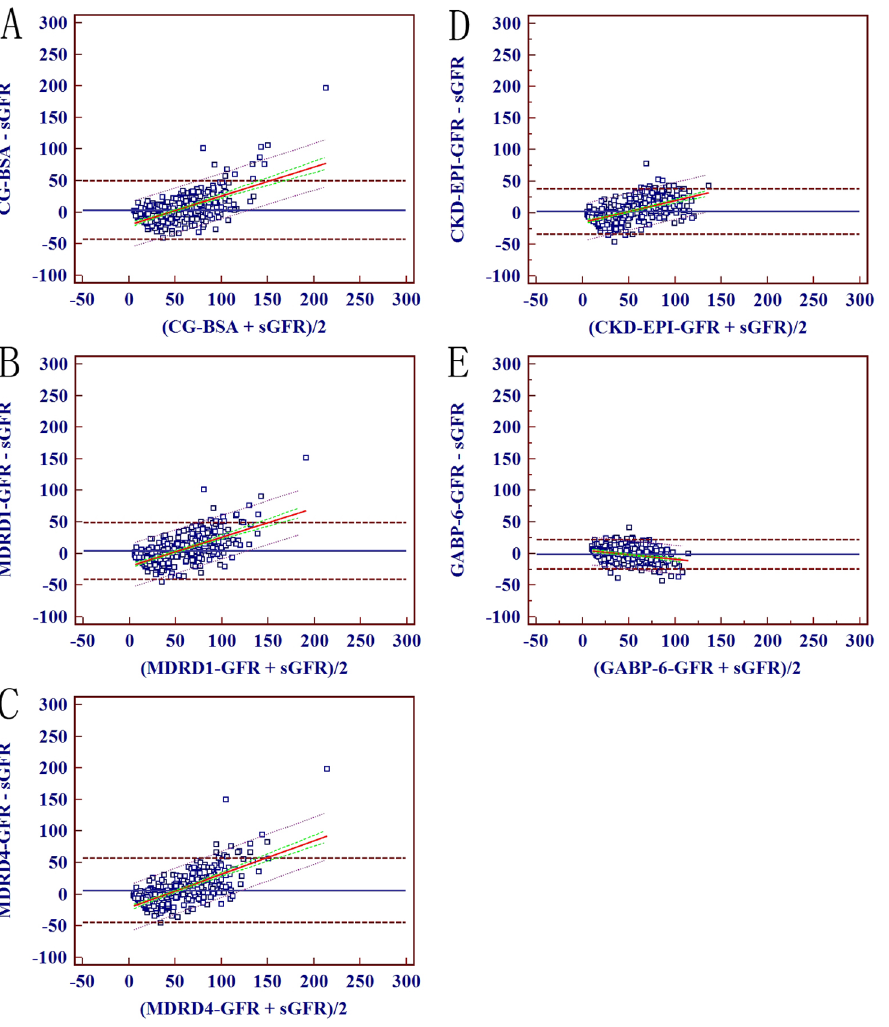
Figure 1. Bland–Altman plot of eGFR and sGFR (ml/min/1.73 m 2 ) in the external validation data set. Solid blue line represents the mean of difference between methods; dashed brown lines represent 95% limits of agreement of the mean of difference between methods; solid red line represents the regression line of difference between methods against average of methods; dotted green lines represent 95% confidence intervals for the regression line, and dashed purple lines represent 95% limits of agreement of the regression line. A, B, C, D and E represent for the results of GFR estimated by the Cockcroft-Gault equation, the six variable MDRD equation, the four variable MDRD equation, the CKD-EPI equation and the six variable GABP network, respectively. Abbreviations: eGFR, estimated glomerular filtration rate; sGFR, standard glomerular filtration; CG, Cockcroft- Gault equation; MDRD: Modification of Diet in Renal Disease; CKD-EPI: Chronic Kidney Disease Epidemiology Collaboration; GABP: BP network with genetic algorithm.